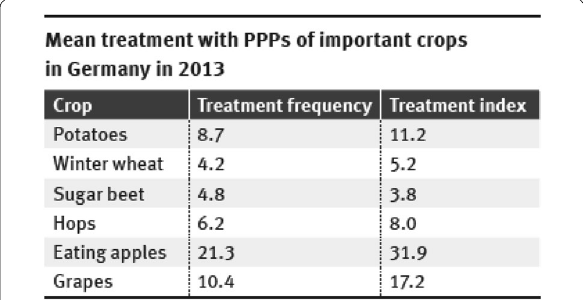
Fig. 1 Mean treatment with PPPs of important crops in Germany in 2013 (our presentation, data from the PAPA Web site of JKI: http:// papa.jki.bund.de/index.php?menuid 1, see also =